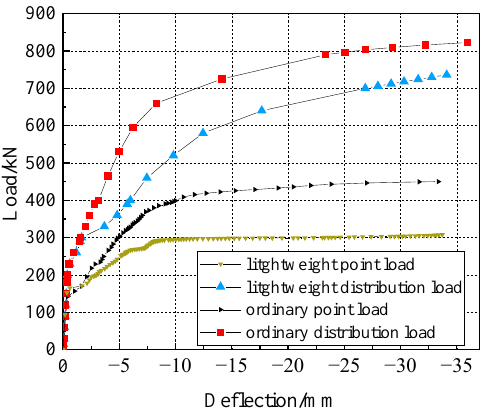
Figure 12. Effect of load type.